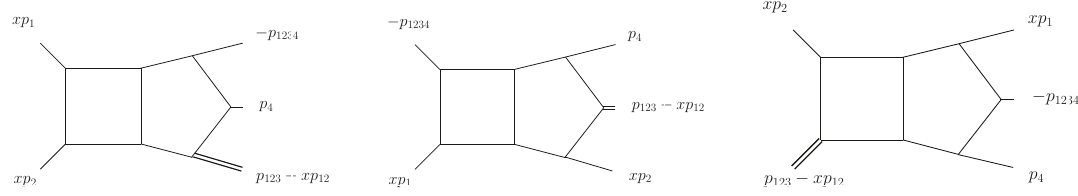
Figure 2 . The two-loop diagrams representing the top-sector of the planar pentabox family P 1 , P 2 and P 3 . All external momenta are